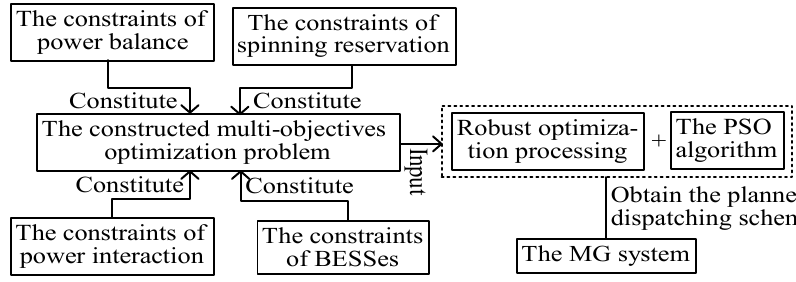
Figure 4. The simplified energy management system.